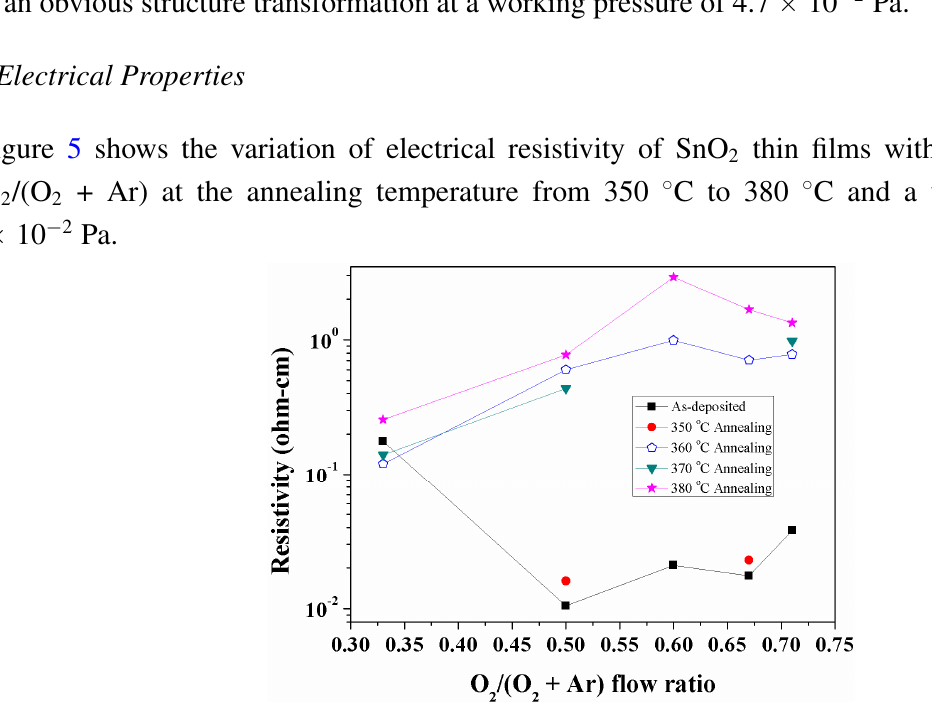
thin films with various flow 2 ´ x